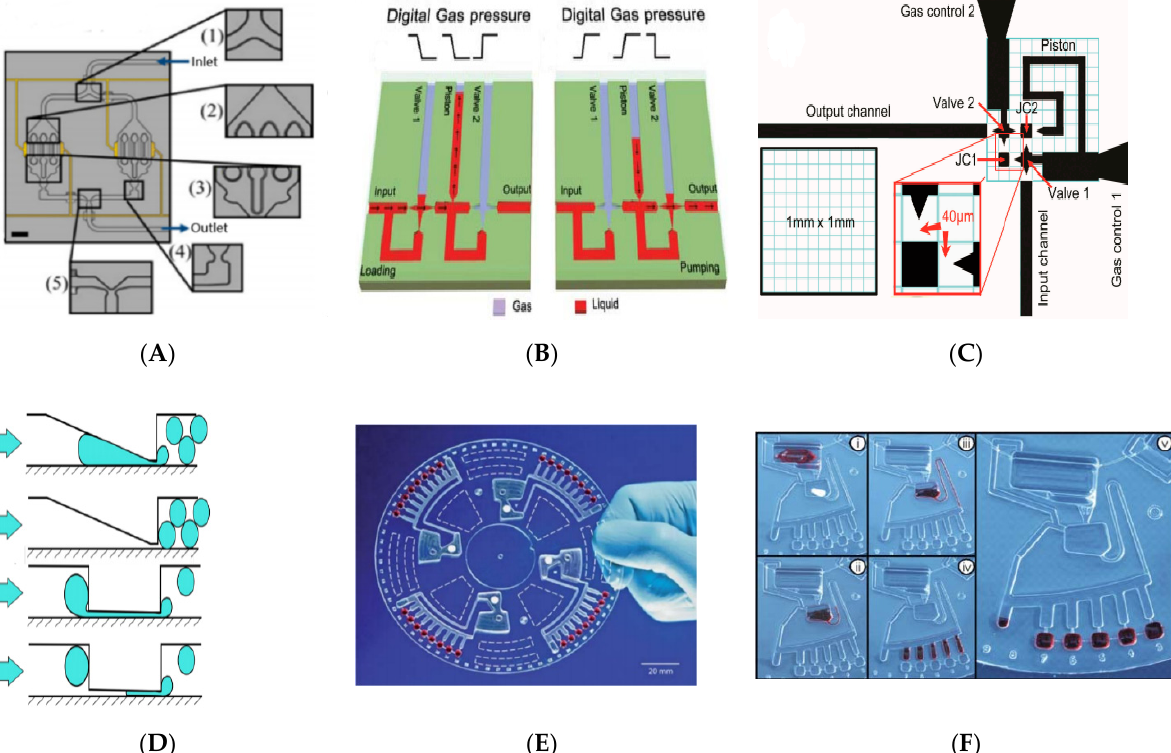
Figure 4. Application of CPCV in different microfluidic scenarios. ( A ) CPCV is used to realize the bubble-free microfluidic network for filling. Reprinted with permission from [119]. Copyright 2014 American Institute of Physics. ( B ) Micropump using CPCV components. Reprinted with permission from [120]. Copyright 2011 Royal Society of Chemistry. ( C ) The optimized micro pump with an area of one square millimeter. Reprinted with permission from [121]. ( D ) Structure of droplet generator using CPCV principle. Reprinted with permission from [122]. Copyright 2017 Royal Society of Chemistry. ( E ) A panoramic view of the lab on disk chip. Reprinted with permission from [123]. Copyright 2010 Royal Society of Chemistry. ( F ) The process of working in a lab on a disk chip. Reprinted with permission from [124]. Copyright 2010 Royal Society of Chemistry.